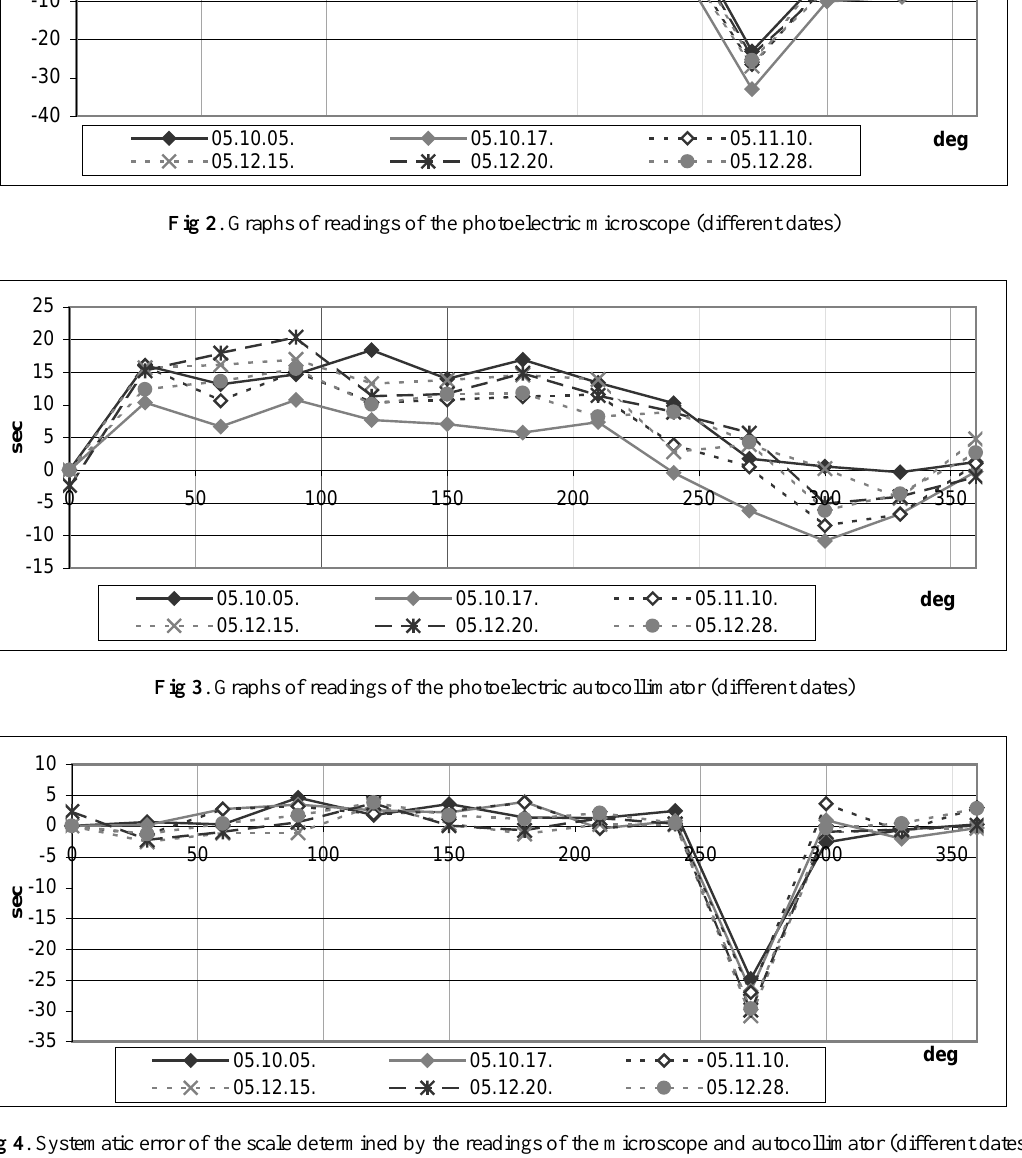
Fig 4 . Systematic error of the scale determined by the readings of the microscope and autocollimator (different